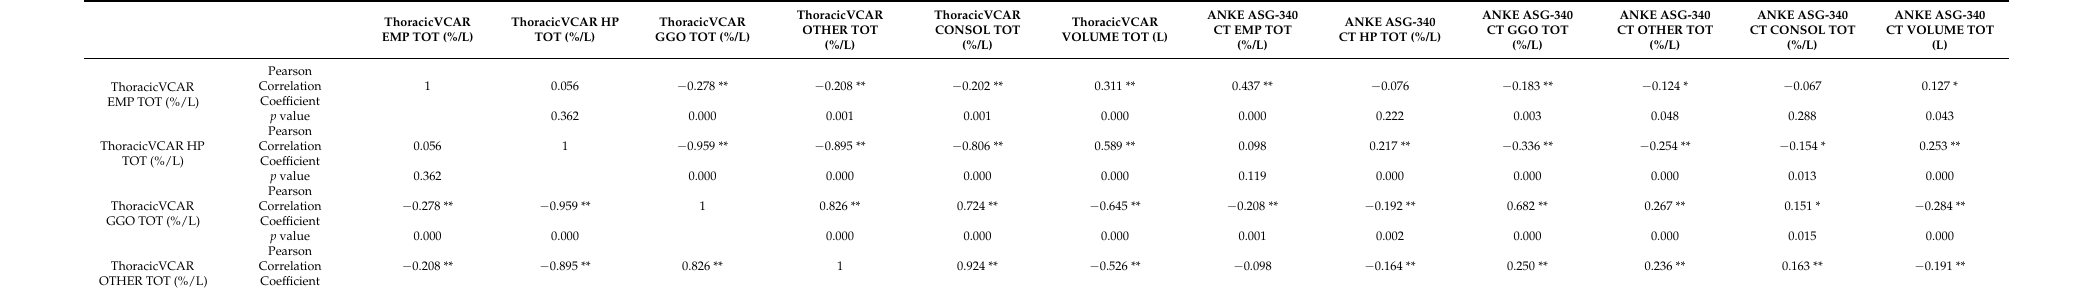
Table 4. Pearson correlation coefficient among quantitative volumes obtained using different